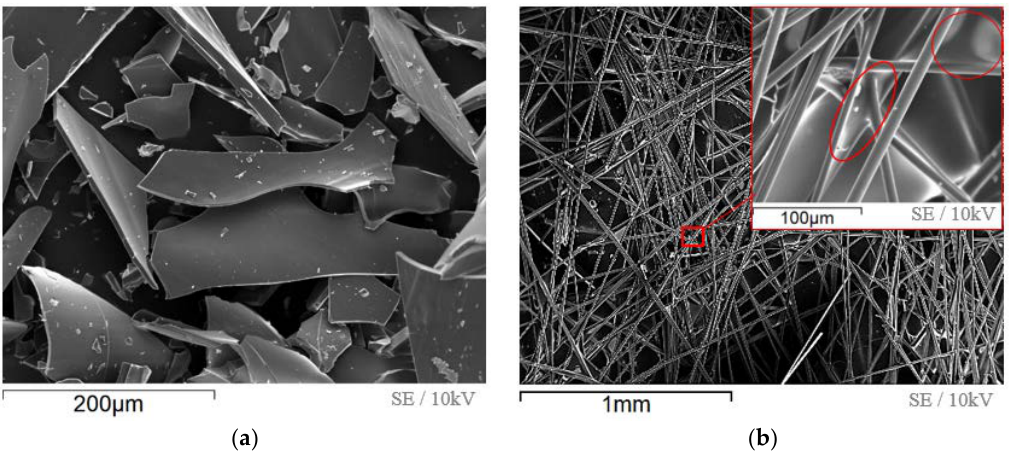
Figure 1. Scanning electron microscopy (SEM) images of the starting materials of a glass composite separator, ( a ) non-ground glass platelets, ( b ) glass fiber nonwoven (Johns Manville, Denver, CO, USA) with binder residues between single glass fibers from the nonwoven manufacturing process (detailed view).